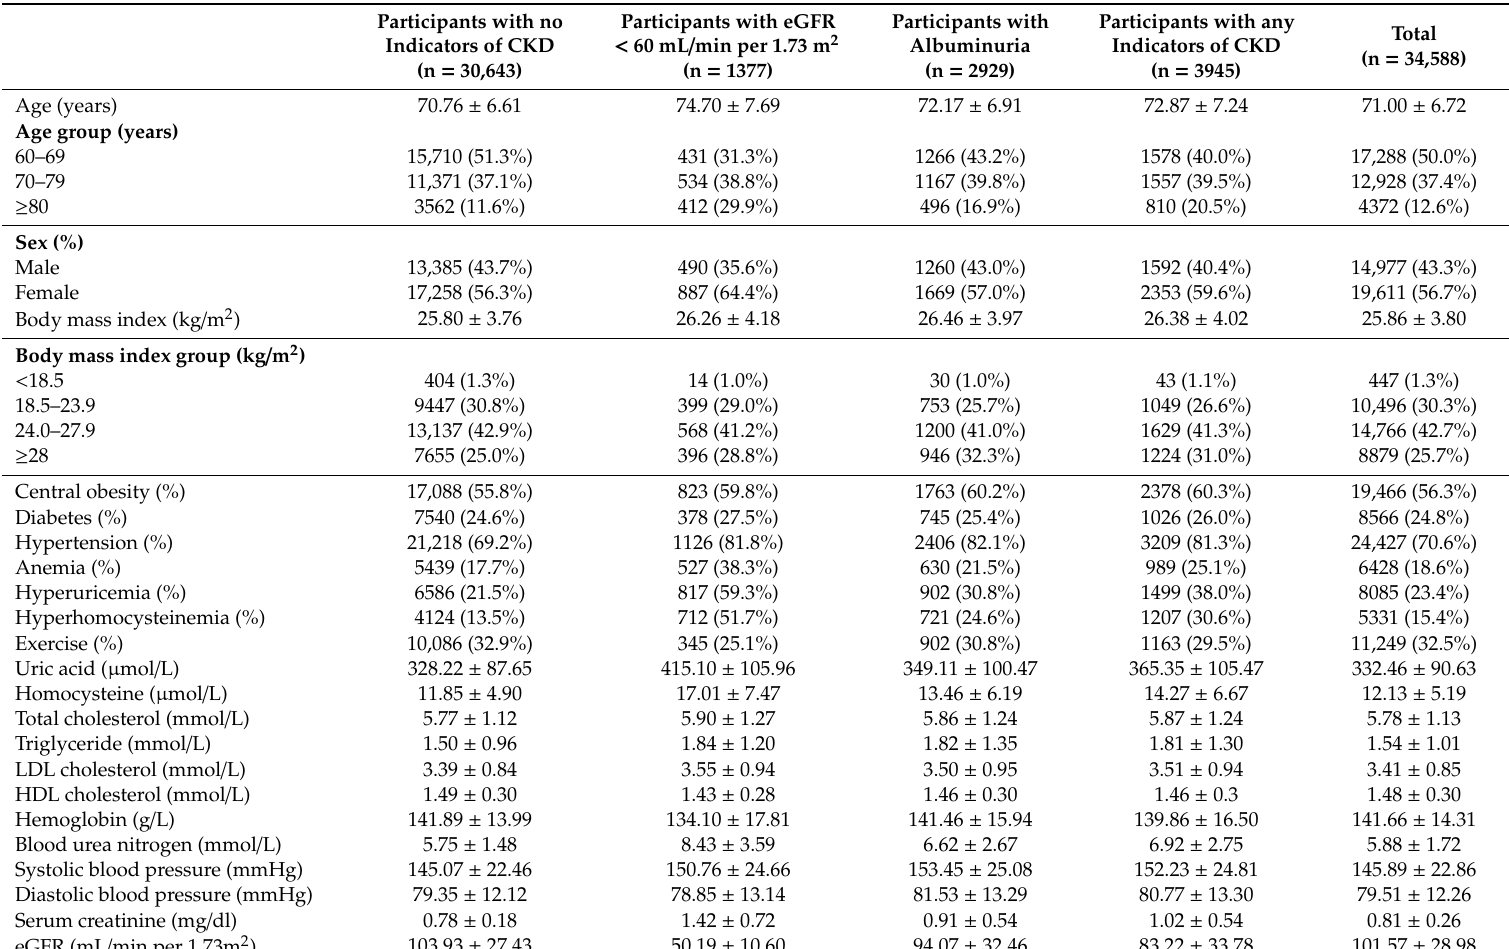
Table 1. Demographic and clinical characteristics of the study